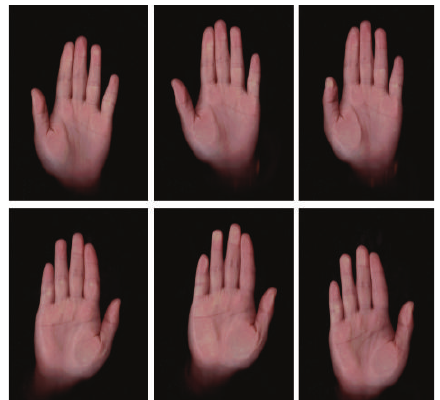
Figure 4: Palmprint images of both hands from female.